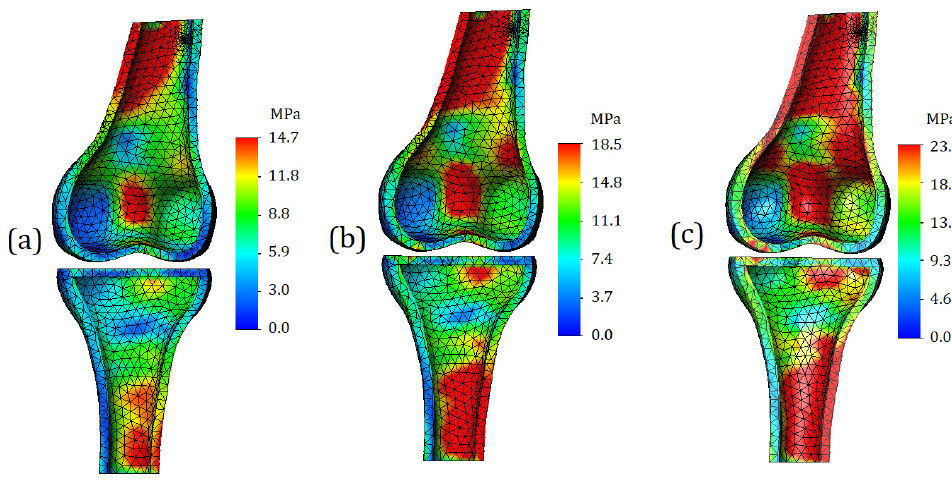
Figure 11. Von Mises stress plots on cortical bone section view in case of running: ( a ) With mild cartilage sti ff ness; ( b ) With moderate cartilage sti ff ness; ( c ) With severe cartilage sti ff ness.